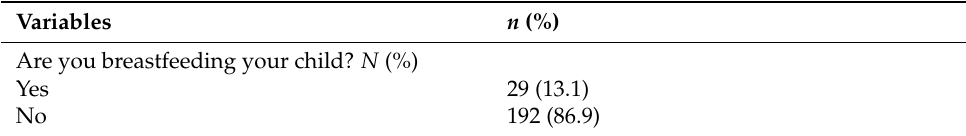
Table 12. Prevalence of breastfeeding at one month